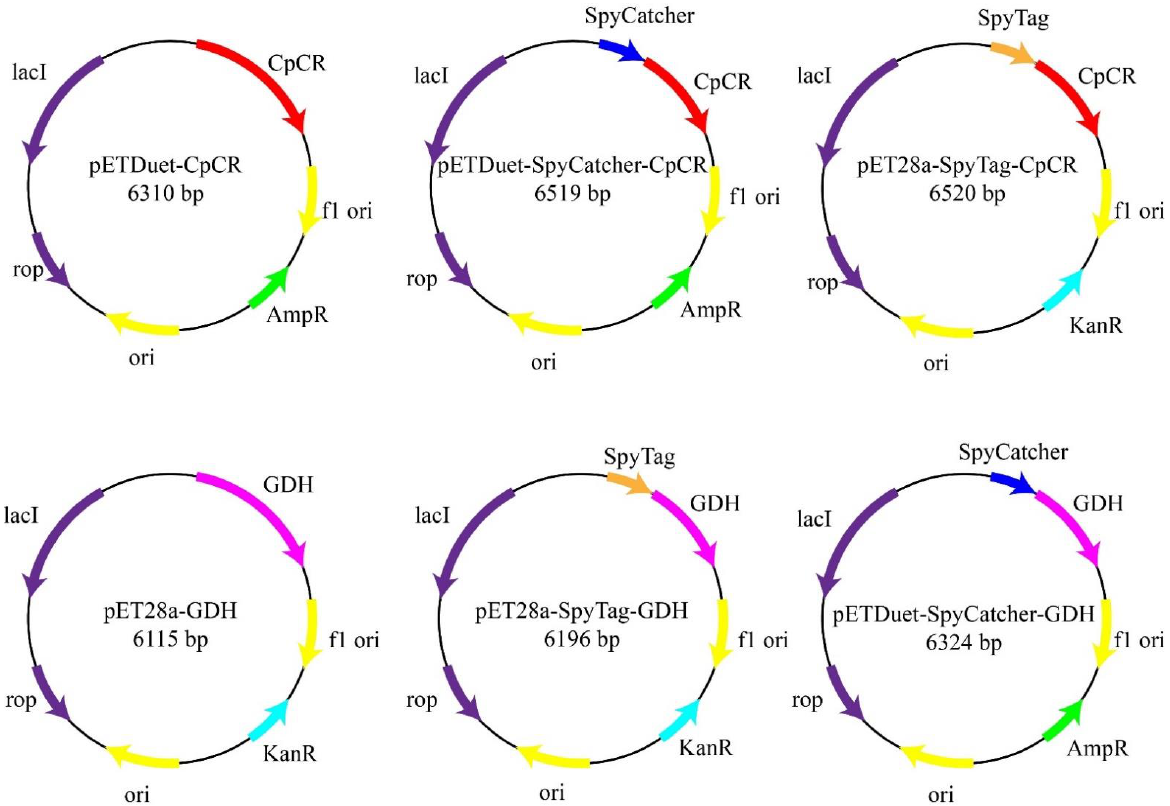
Figure 4. Construction of carbonyl reductase and glucose dehydrogenase fusion enzymes with SpyCatcher and SpyTag, respectively.